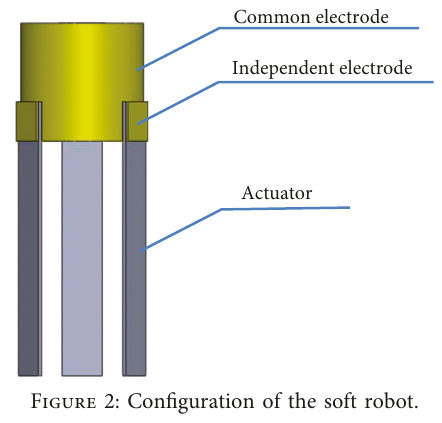
Figure 2: Configuration of the soft robot.